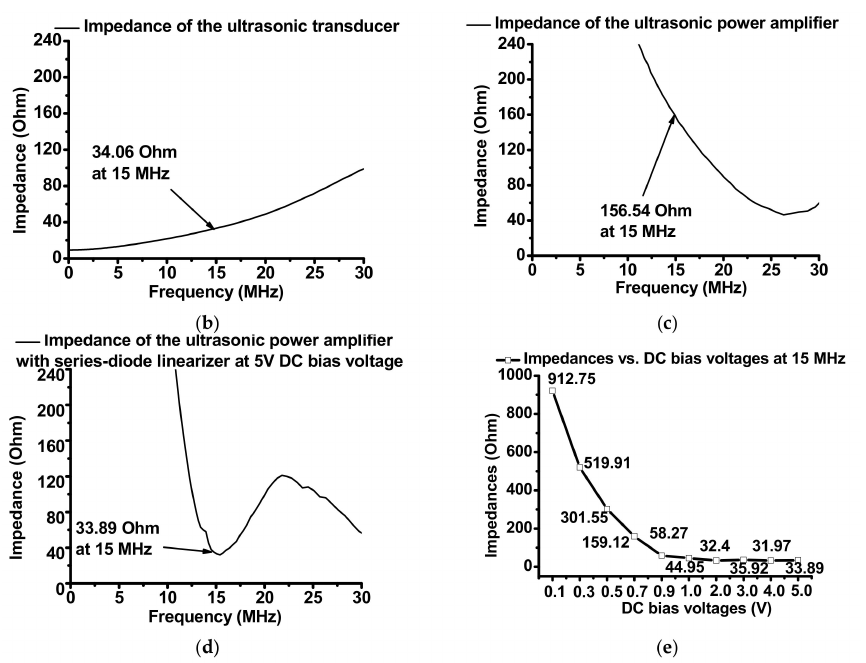
Figure 4. ( a ) Measurement setup of electrical impedances of the isolated ultrasonic power amplifier and the ultrasonic power amplifier integrated with series-diode linearizer; ( b ) electrical impedances of 15 MHz ultrasonic transducer; ( c ) the isolated ultrasonic power amplifier; ( d ) ultrasonic power amplifier integrated with series-diode linearizer at 5 V DC; ( e ) electrical impedances of the ultrasonic power amplifier with series-diode linearizer at 0.1 V, 0.3 V, 0.5 V, 0.7 V, 0.9 V, 1 V, 2 V, 3 V, 4 V, and 5 V DC bias voltages at 15 MHz.